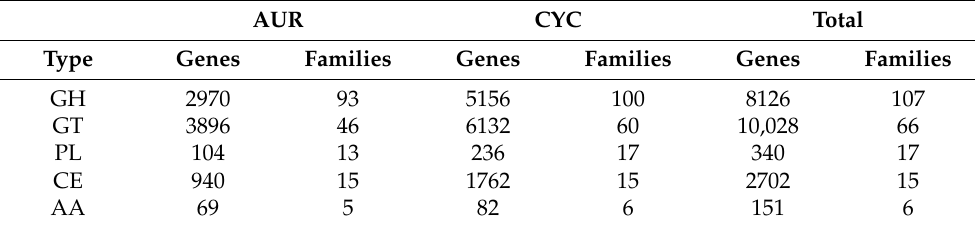
Table 1. Prediction of CAZymes in the metagenomic samples. Classification of the putative CAZymes found in each sample. GH, glycoside hydrolase; GT, glycoside transferase; PL, polysaccharide lyase; CE, carbohydrate esterase; AA, auxiliary